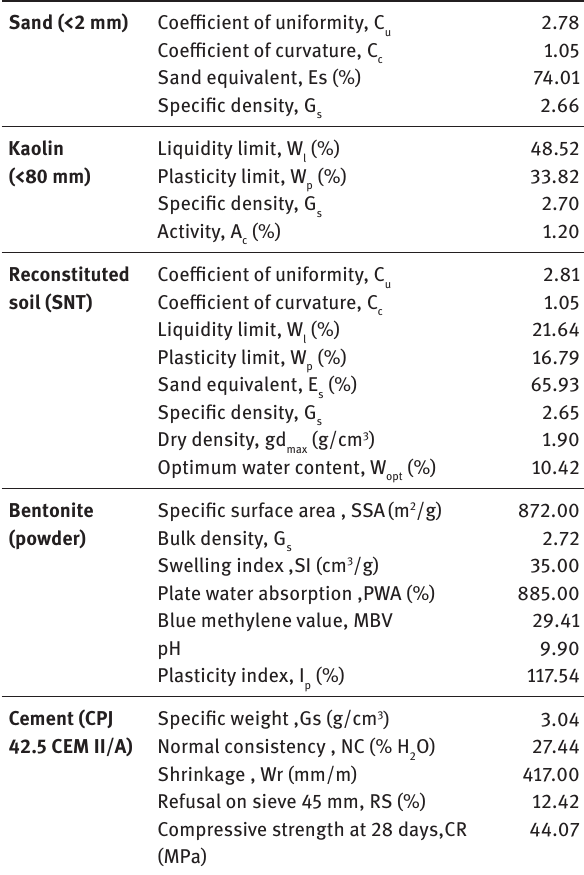
Table 2: Geotechnical characteristics of different soils. Sand (<2 mm) Coefficient of uniformity, C